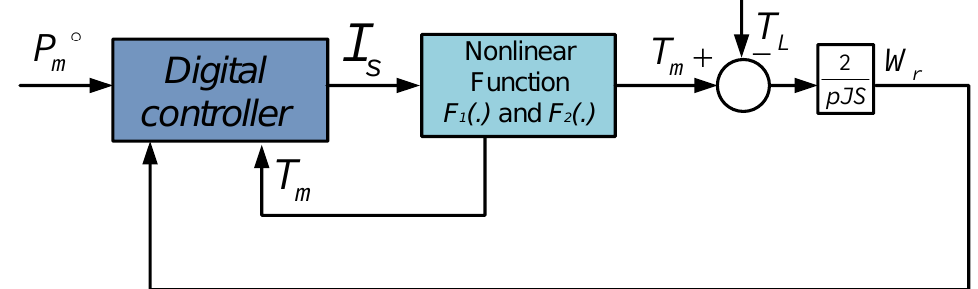
Figure 5. Power-based closed loop